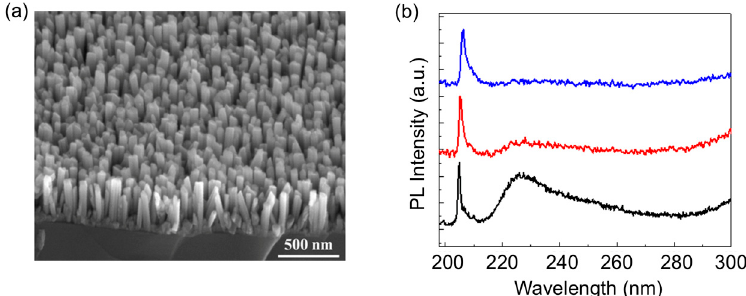
Figure 7. ( a ) SEM image of Mg-doped AlN nanowires. ( b ) Photoluminescence spectra of Mg-doped AlN nanowire samples measured at 20 K. As the Mg-doping concentration increases, Mg-acceptor related radiative recombination becomes more pronounced (from the top spectrum to the bottom spectrum) [85].